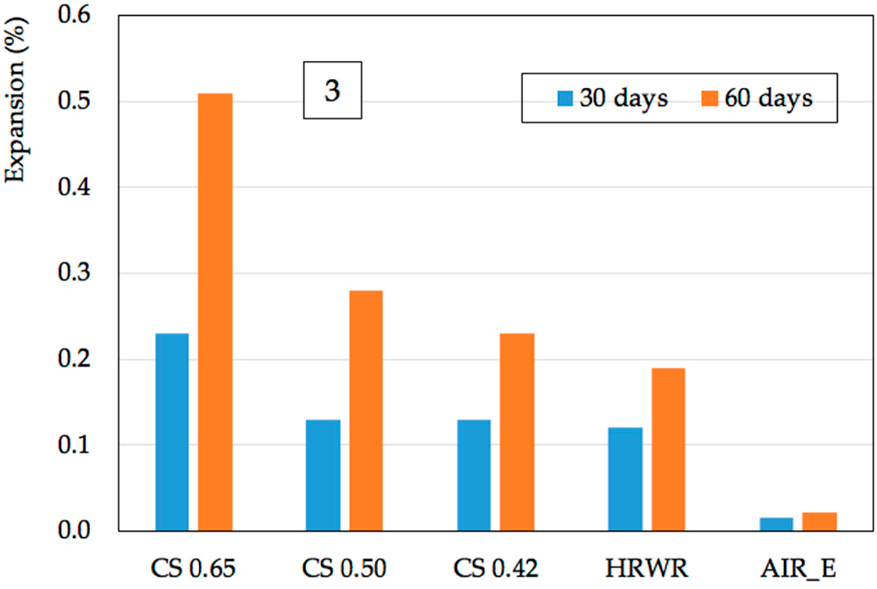
Figure 8. Expansion according to Procedure 3 (38 °C and R.H. 100%).